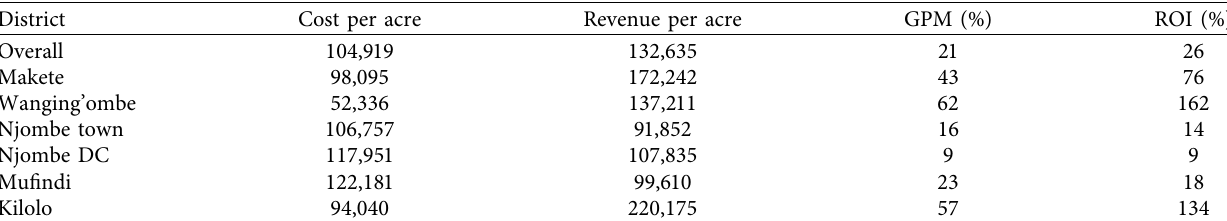
Table 5: Statistics of profitability in various study sites.